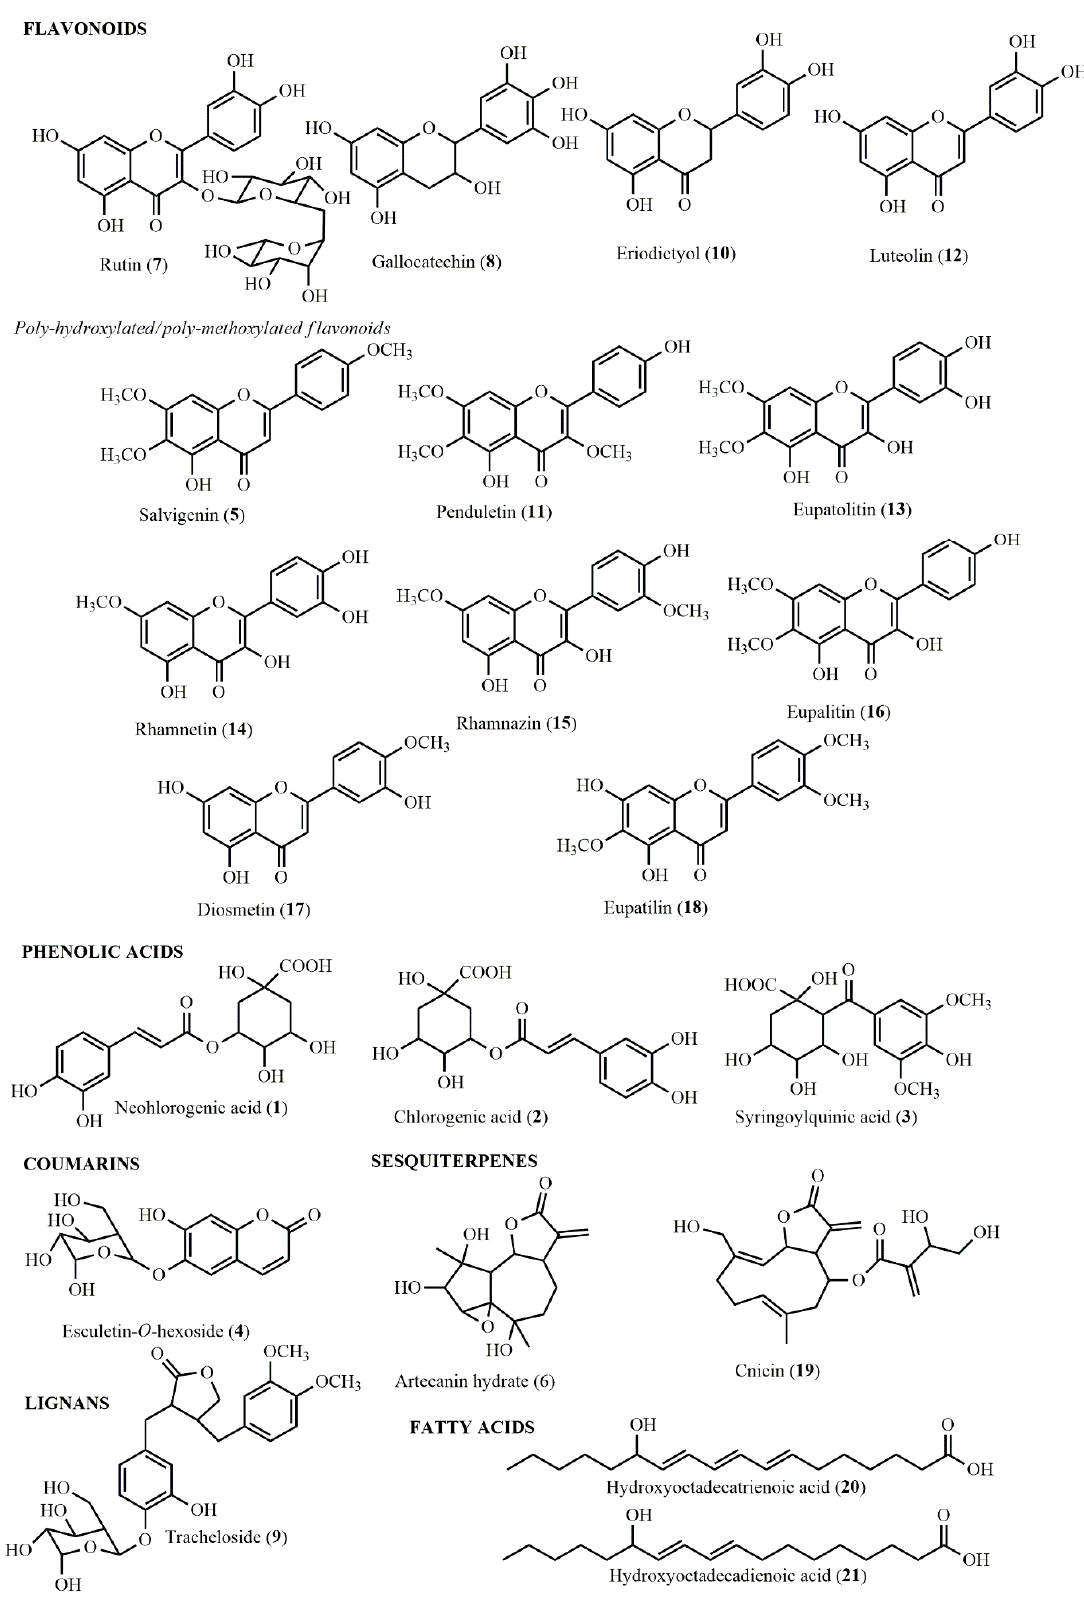
Figure 2. Chemical structures of the compounds tentatively labeled in the A. campestris subsp. lednicensis aerial part extracts.